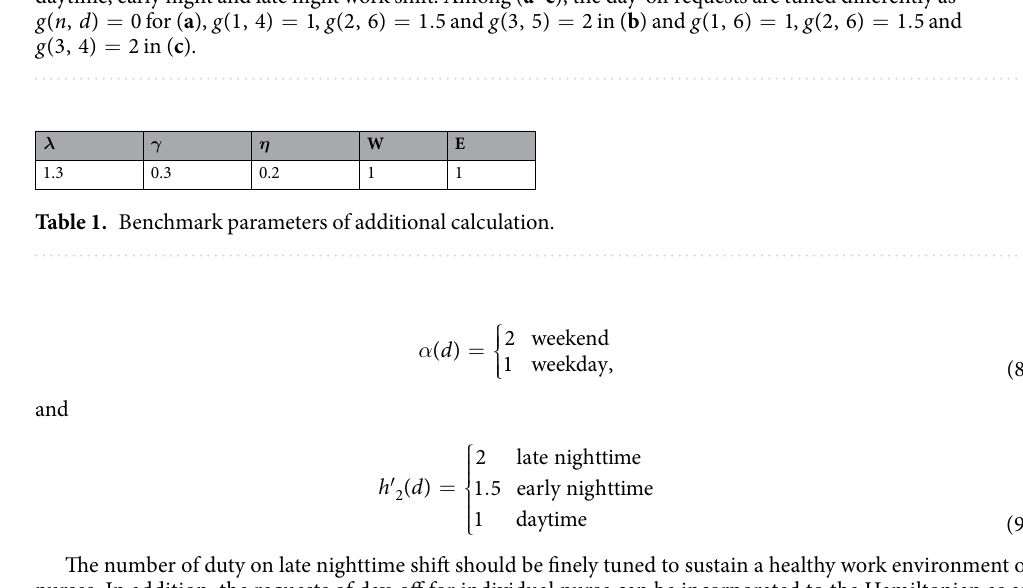
Figure 9. Solutions of the proposed three-shift NSP with additional constraints. DT, EN and LN refer to daytime, early night and late night work shift. Among ( a – c ), the day-off requests are tuned differently as